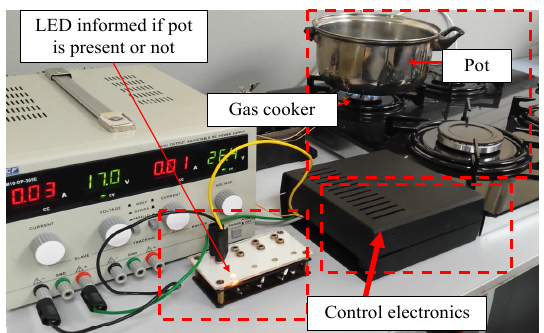
Figure 21. Photo of the test stand with the electronics.